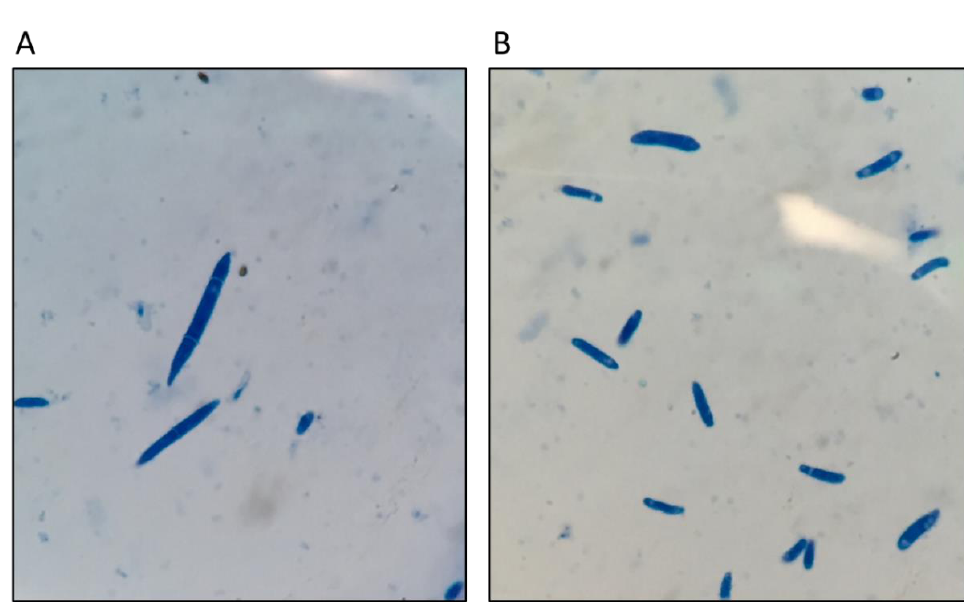
Figure 2. Microscopic morphology of Fon ( A ) macroconidia, and ( B ) microconidia. When on a susceptible host plant, the mycelia then penetrate the root to the xylem where the infection continues and other spore types are produced. Penetration of the plant host can occur through natural openings/cracks in the root but is increased by physical wounds that occur in the root surface. Microconidia are generated primarily in the xylem space and travel with the flow of water from one vessel cell to the next, germinating at the end and producing more microconidia on the opposite side of the vessel cell wall. Cell